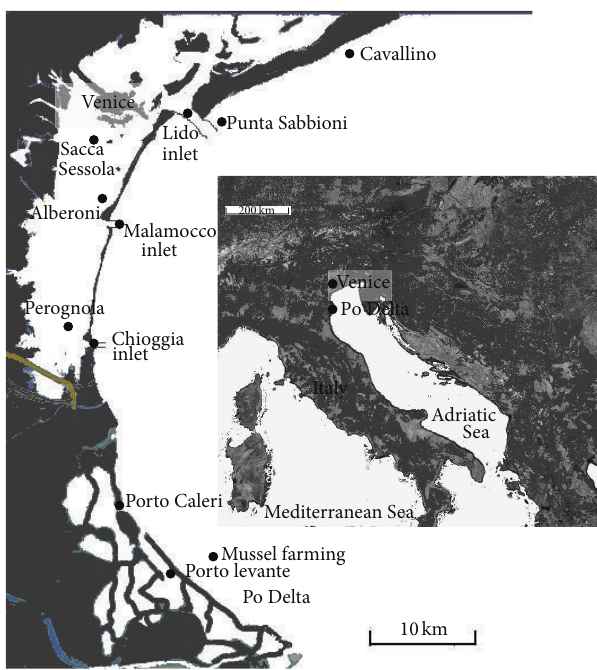
Figure 1: Map of the study area. The sampling sites are marked by black